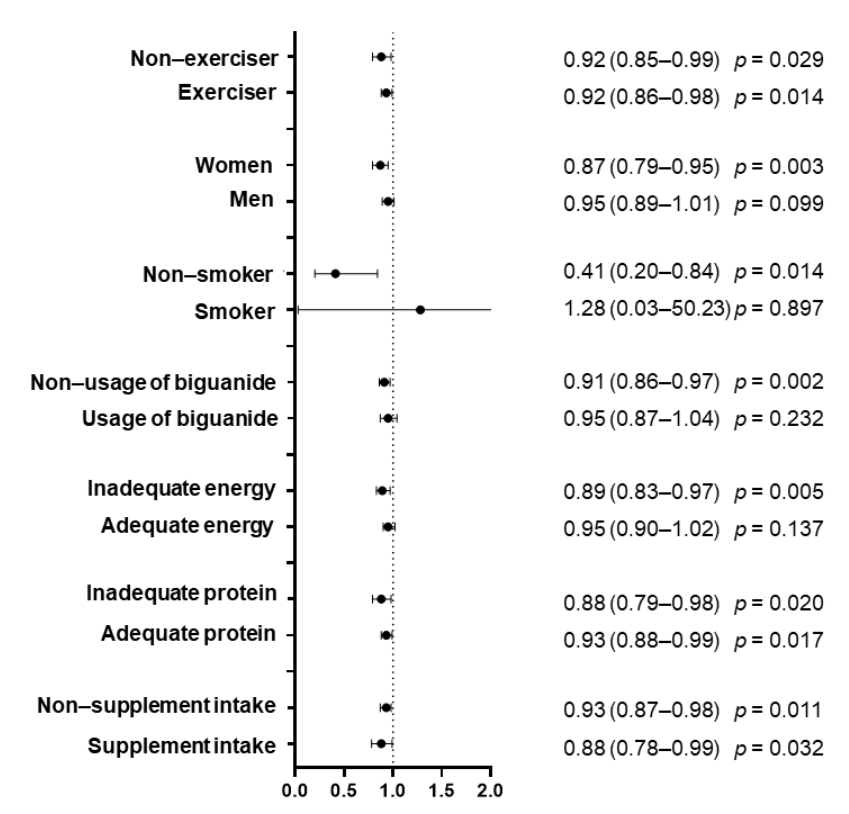
Figure 2. Odds ratio of vitamin D intake on the loss of muscle mass according to the groups.